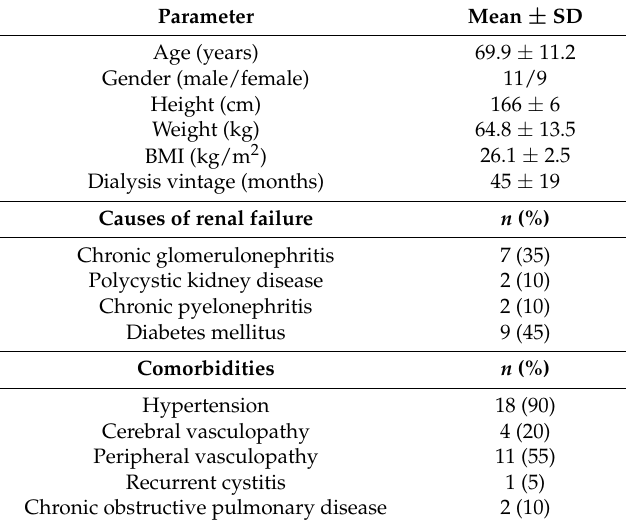
Table 1. Characteristics of the 20 hemodialysis